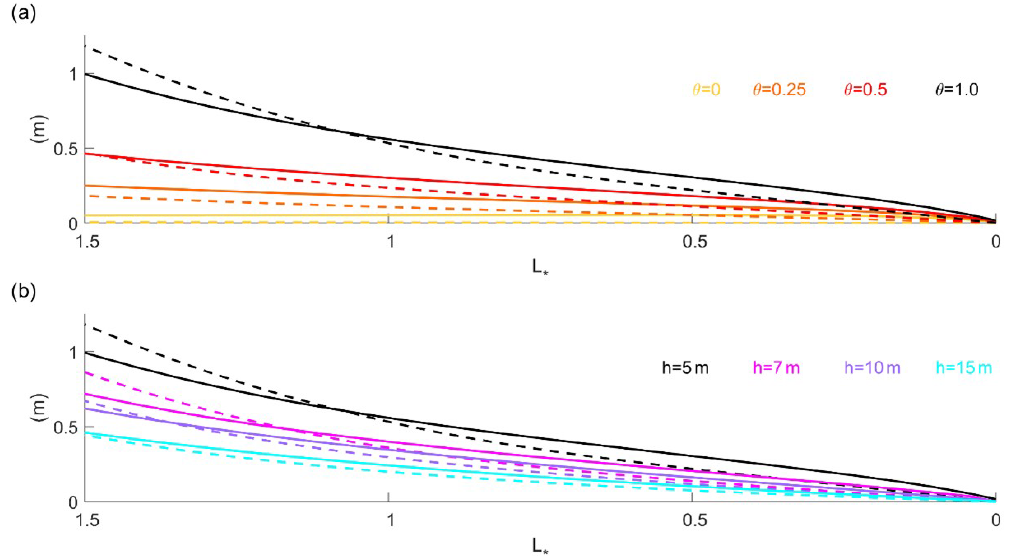
Figure 4. (a) The importance of river flow (i.e., θ at L ∗ = 1 . 5) for 5m depth and (b) the importance of channel depth for θ = 1 in an idealized three-wave model. The vertical axis is tidally averaged water level and horizontal axis represents dimensionless coordinate system of L ∗ = x/L e . Solid and dashed lines represent numerical and analytical model results, respectively. The solid and dashed black lines represent the same scenario ( h = 5m, θ = 1) in both (a) and (b) .